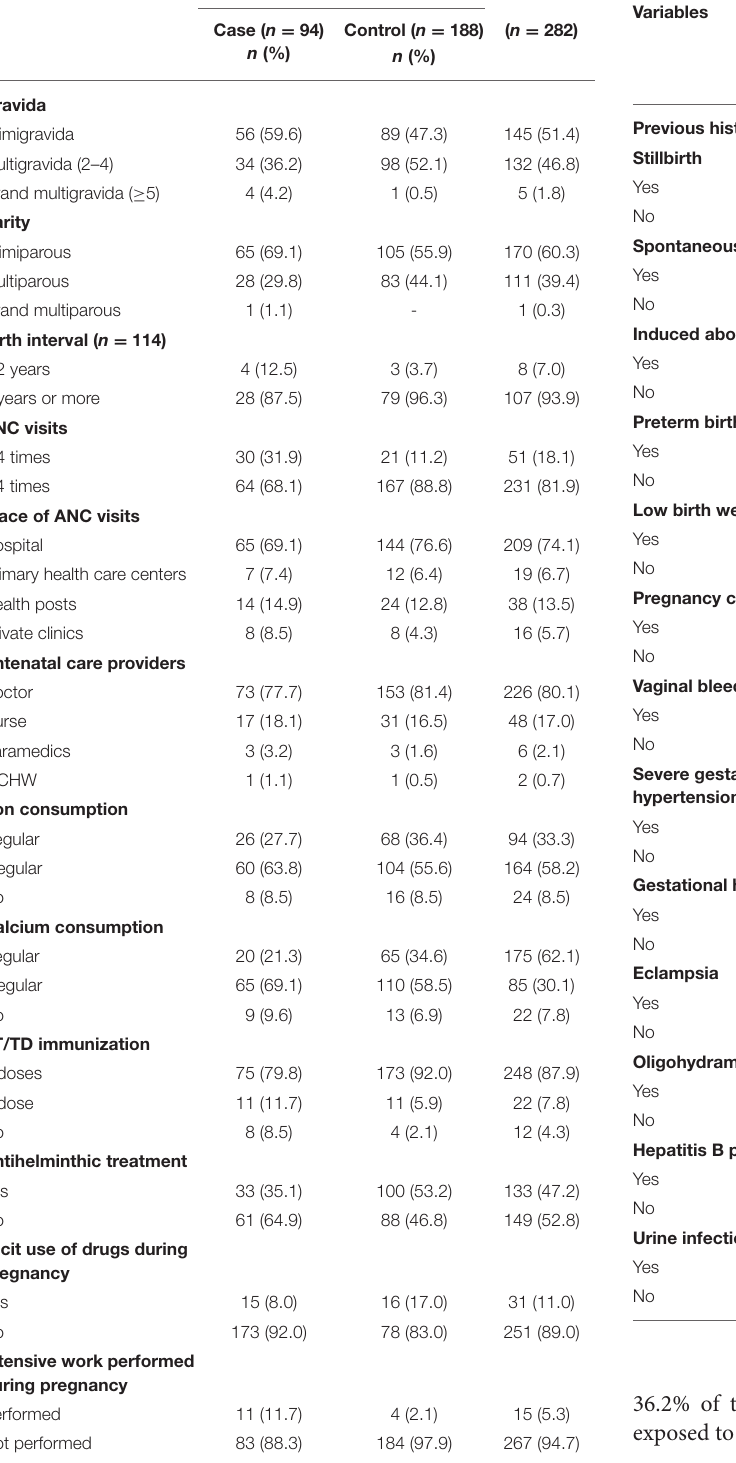
TABLE 3 | Pregnancy-related characteristics of the study participants. TABLE 4 | Previous histories and antenatal complication-related characteristics of the study